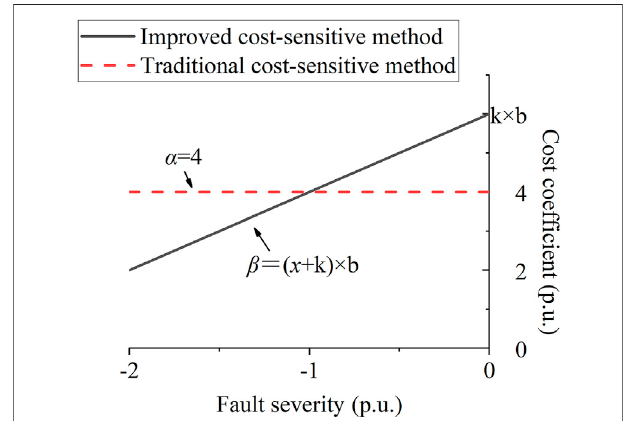
FIGURE 2 | Cost sample based on fault